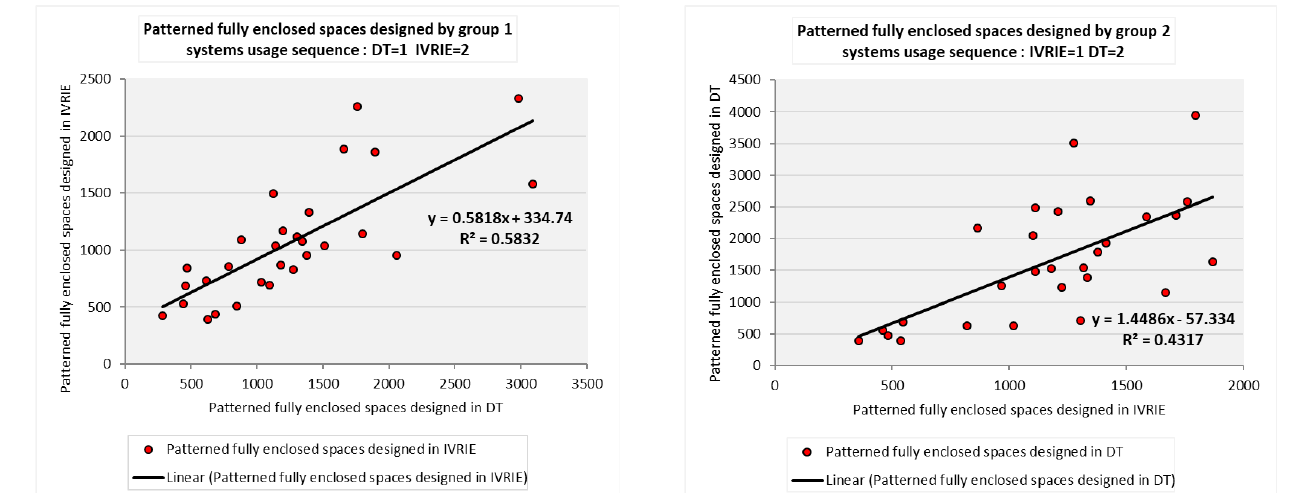
Figure 15. Linear regressions for patterned, fully enclosed spaces designed in IVRIE and the DT system by both groups of participants.